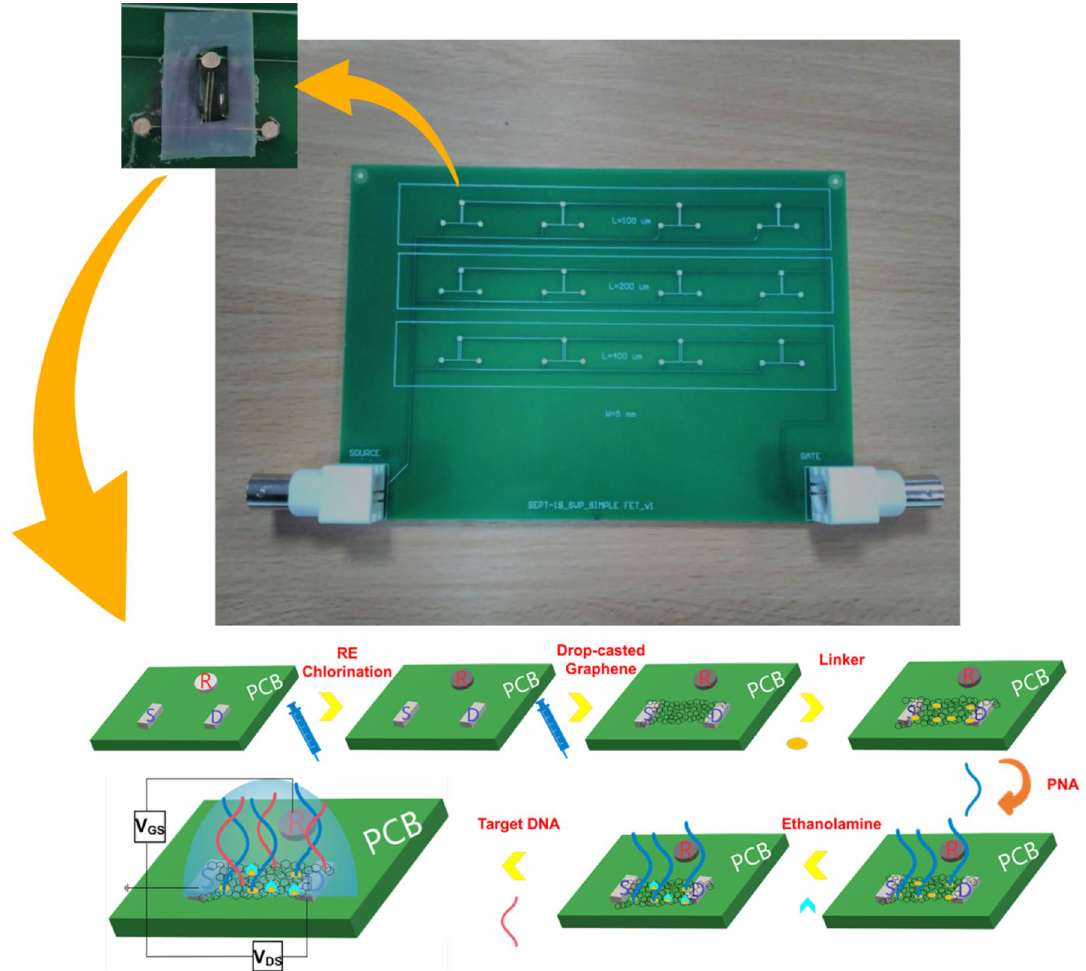
Figure 1. Top: Photograph of the printed circuit board (PCB) designed in Altium for evaluation of graphene as the channel material of electrolyte-gated FET. In magnification, one of the devices where the drain, source, gate electrodes are visible along with the drop-casted graphene channel. Self-adhesive Teflon tape was attached to confine the electrolyte droplet. Bottom: Schematic of assay steps for PNA-DNA hybridization detection employing an electrolyte-gated graphene field-effect